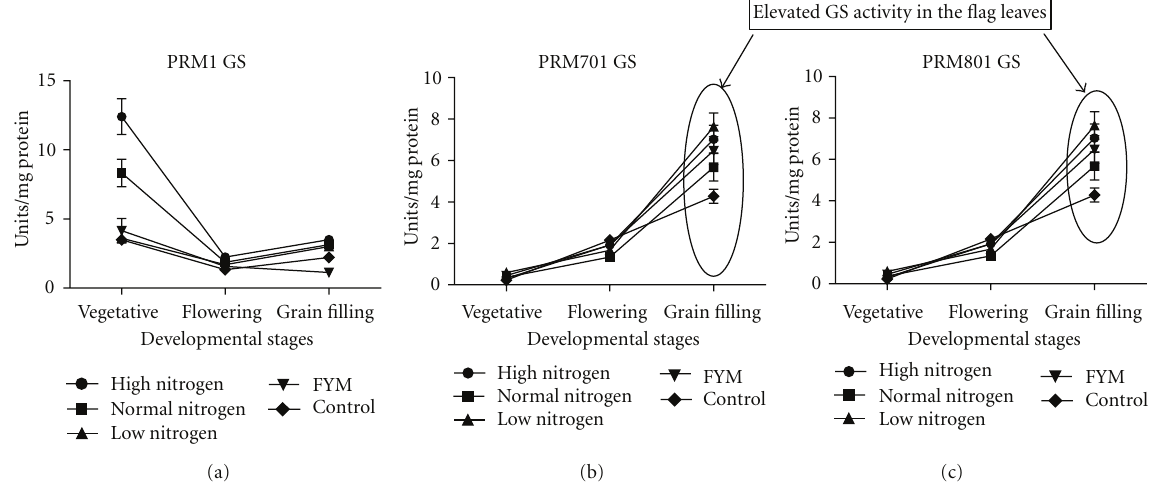
Figure 3: Influence of nitrogen fertilization on glutamine synthetase (GS) enzyme activity (specific activity) at various developmental stages of finger millet genotypes (a) brown PRM-1, (b) golden PRM-701, (c) white PRM-801